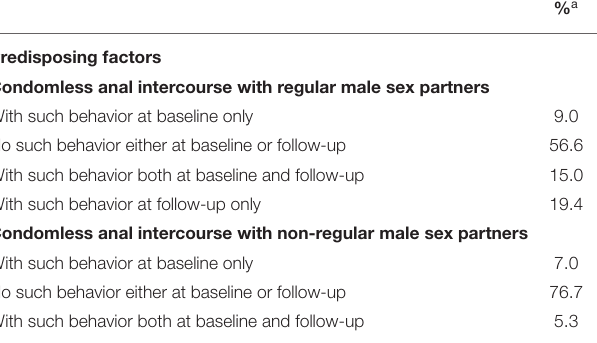
TABLE 3 | Comparing HIV testing behaviors and sexual behaviors in the past 6 months measured at baseline and follow-up ( n = 412). Baseline Follow-up a P % a